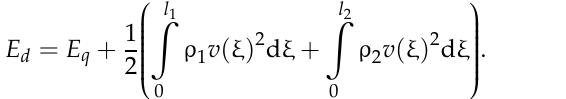
Figure 9. Velocity and crushed distance of the front plate for a positive gradient foam. g = 0.3. Table 6. Comparisons of average cross-section thicknesses of deformed specimens.